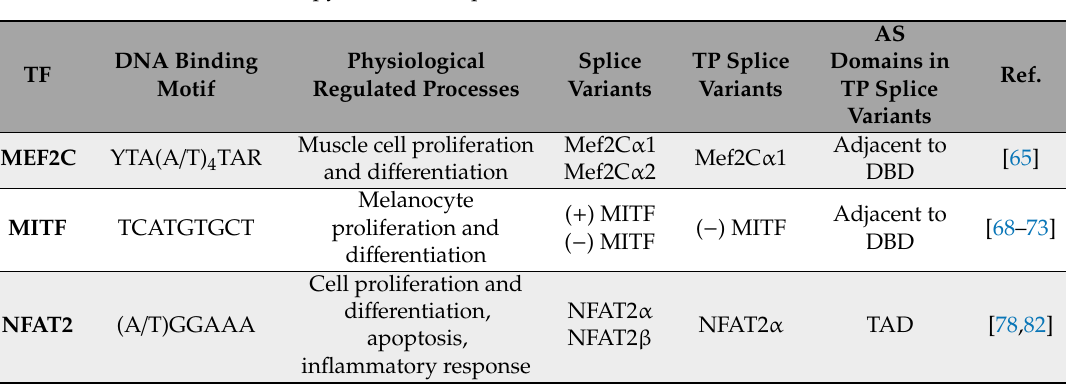
Table 2. Transcription factors (TFs) and respective splice variants with oncogenic properties characterized by di ff erent activating / repressing ability on the same target genes physiologically regulated by isoforms expressed in normal cells. Tumor-promoting (TP) splice variants with clinical correlation data and relative AS domains have been listed. DBD (DNA binding domain), TAD (transactivation domain), Y (pyrimidine), R